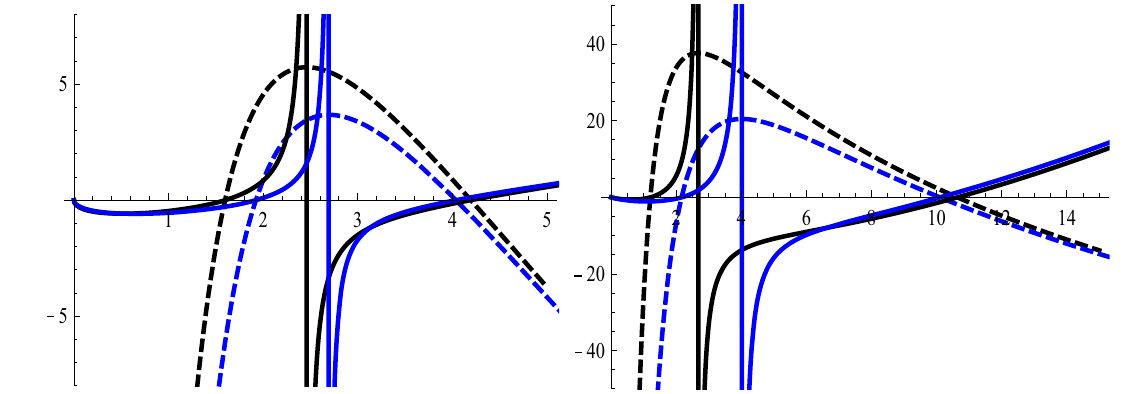
√ 3 , Q = 2 , b = 1 , a = 2 ( black ), 5 ( blue ) .